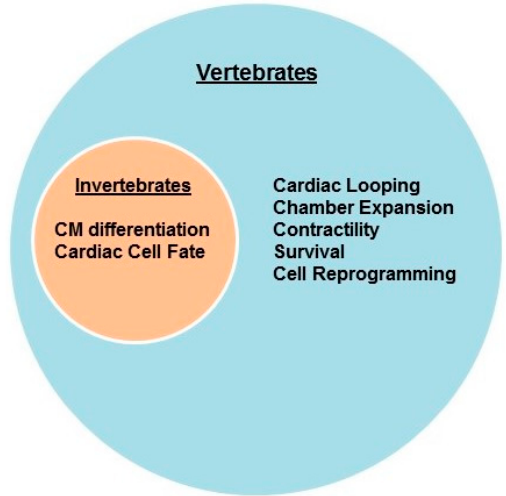
Figure 1. Schematic of process regulated by the MEF2 family of transcription factors. The core cardiac transcription factor MEF2 is a key regulator of cardiac development and some of the gene programs it regulates have been evolutionarily conserved. Invertebrate MEF2 and certain isoforms of vertebrate MEF2 have been shown to be important in regulating cytoarchitectural gene transcription (overlapping region). Non-overlapping regions depict those gene programs/cellular processes that have been shown to be regulated by either the invertebrate or vertebrate only MEF2